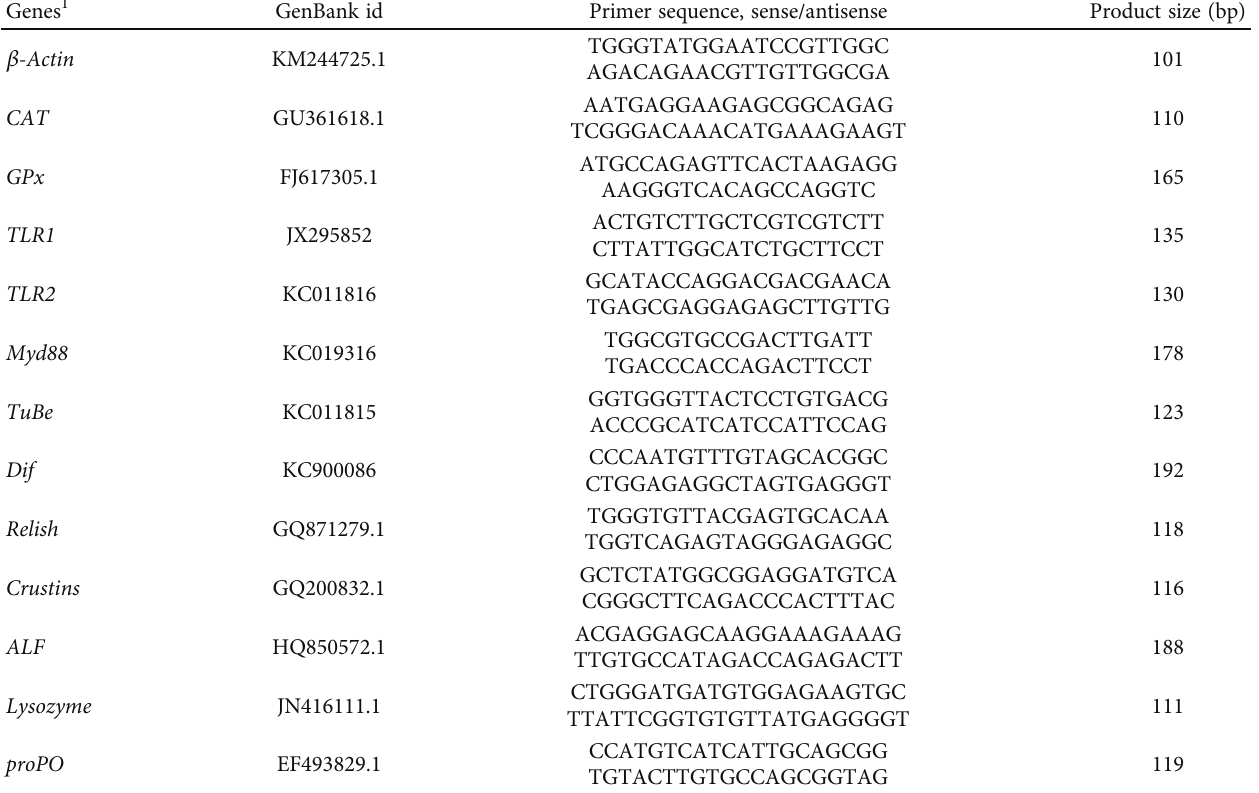
Table 2: Primer sequence for real-time PCR